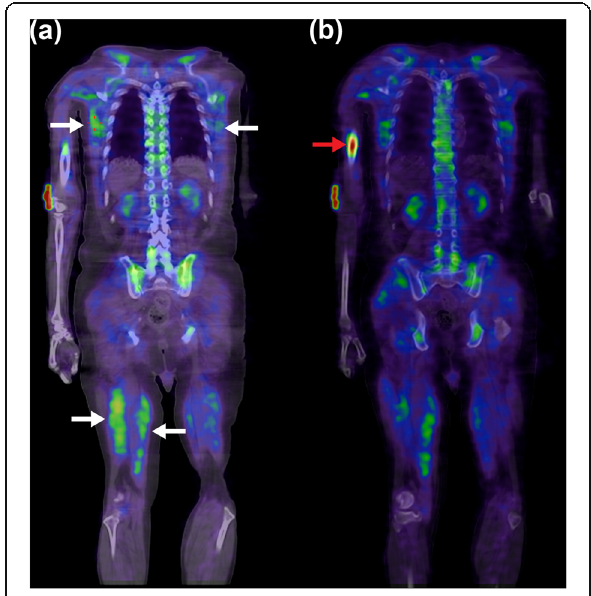
Fig. 2 Fused bone SPECT/CT in coronal view. a Image in soft tissue window showing diffuse intense uptake at the bilateral pectoralis muscles, muscles around the scapular, tensor fascia lata and quadriceps femoris (white arrows). b Image in bone window highlights that there is no pathology in the adjacent bones; however, a focus of increased tracer uptake seen in the mid shaft of right humerus corresponds to a sclerotic lesion on CT, likely a healing fracture (red